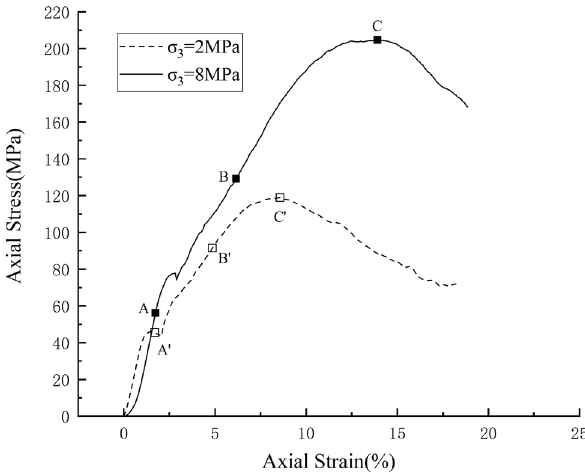
Figure 6. The stress–strain curves of simulations.